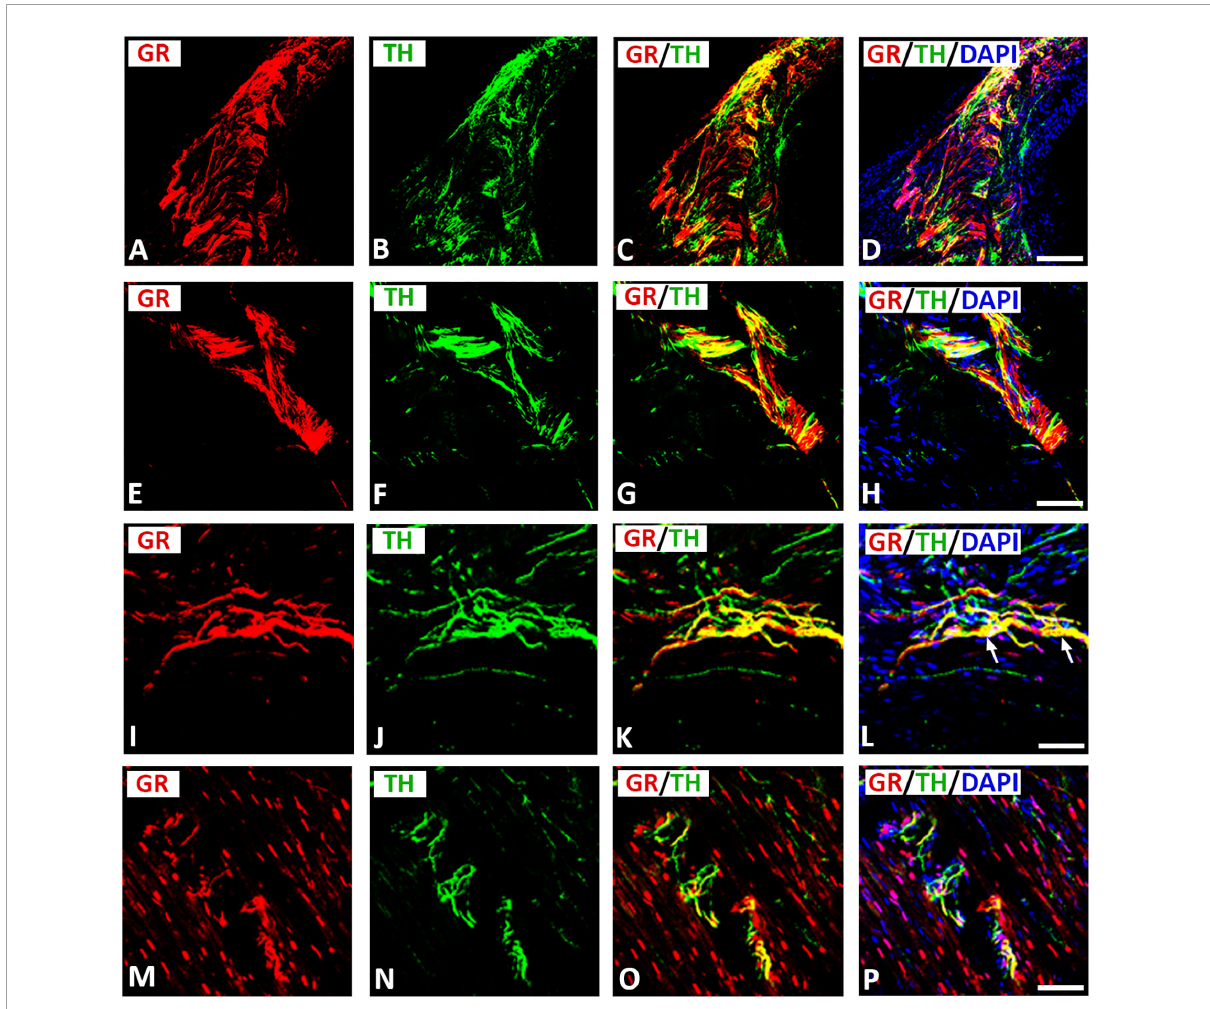
FIGURE5 Confocal microscopy of GR (A,E,I,M) ( red fluorescence ) and sympathetic neuronal marker tyrosine hydoxylase (TH) ( B,F,J,N ) ( green fluorescence ) double immunofluorescence of nerve terminals within atria (I-P). (A–D) Show colocalization ( yellow fluorescence ) of GR with TH-immunoreactive network of nerve fibers within rat atria, however some nerve fibers express only GR or TH. (E–L) Show GR expressed in TH-immunoreactive nerve bundles (arrow) or single axons of epicardial nerve within rat atria. (M–P) Show TH-positive nerve fibers running in small bundles within the myocardium coexpressing GR ( yellow fluorescence ). Note, many cardiomyocyte nuclei express GR. (D,H,L,P) Show DAPI nuclear staining ( bright blue ). (A–P) = 40 µ